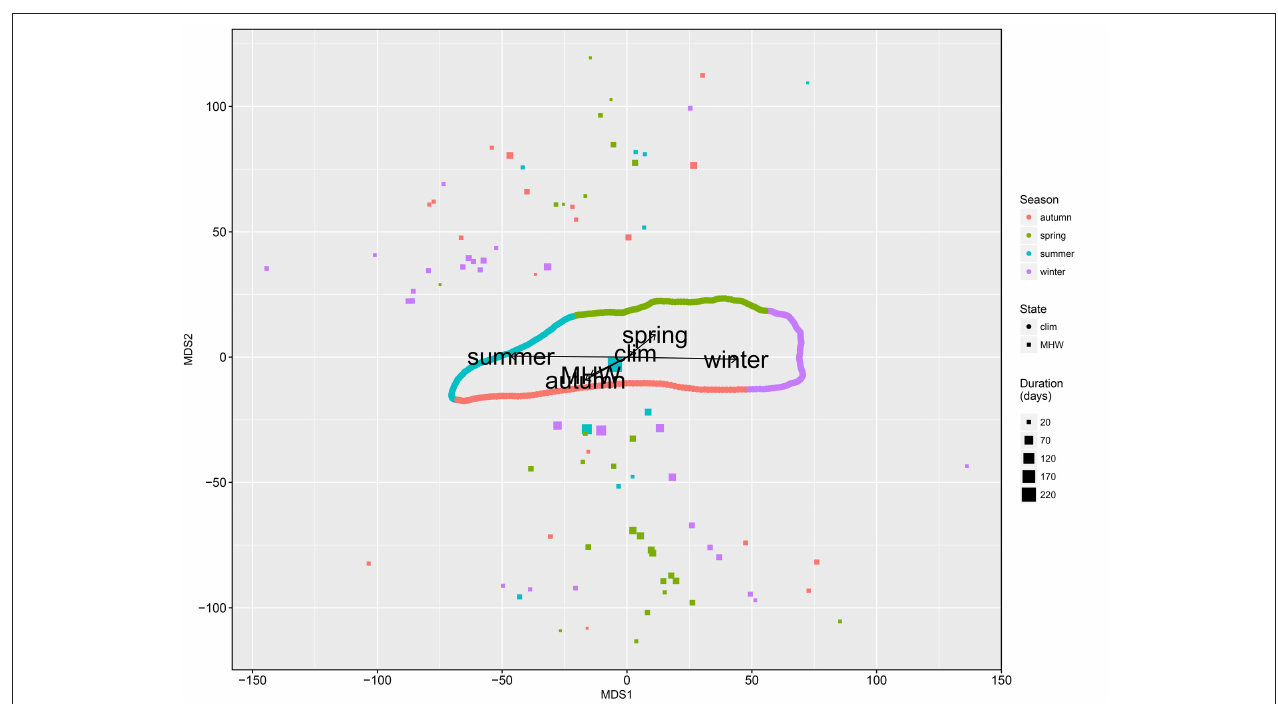
FIGURE 3 | Biplot (stress = 0.14) showing the ordination of climatology (clim) states (circles) and marine heatwave (MHW) states (squares). The x and y axes are not representative of any specific values of the states, rather the distance between each point shows the best fitting relationship of all states with one another based on the output of a nonmetric multidimensional scaling (NMDS) model. The season of the year during which the state occurred/started is shown in color. The influence of the two categorical variables, type of atmosphere-ocean state and season of occurrence, on the placement of each state in the two-dimensional space are shown as black labeled vectors. Note that the clim states (circles) are plotted so tightly together that they do not appear as individual points. The duration of the MHW states (not the clim states) are indicated by the size of the square